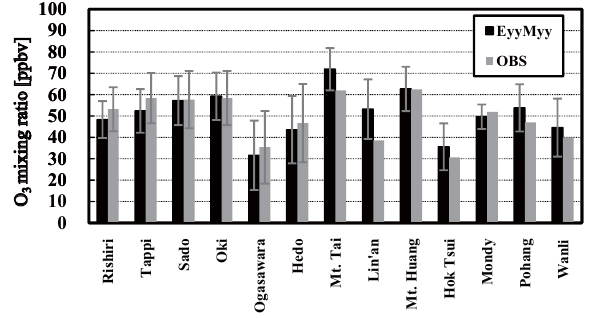
Fig. 2. Comparison of the springtime averaged O 3 mixing ratios between observations (gray bars) and model simulations by E yy M yy (black bars). Locations and general information on monitoring sites are presented in Fig. 1 and Table 2, respectively. Data from all periods shown in Table 2 were included in the calculation of the springtime average and standard deviation at each site. The whiskers indicate 1 standard deviation for both observation and simulation. Several observations without whiskers were taken from published research papers.